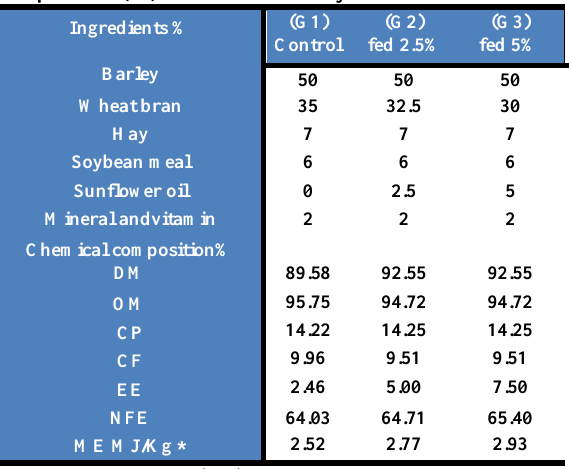
Table, 1: Formulation of the experimental dietary composition (%) and chemical